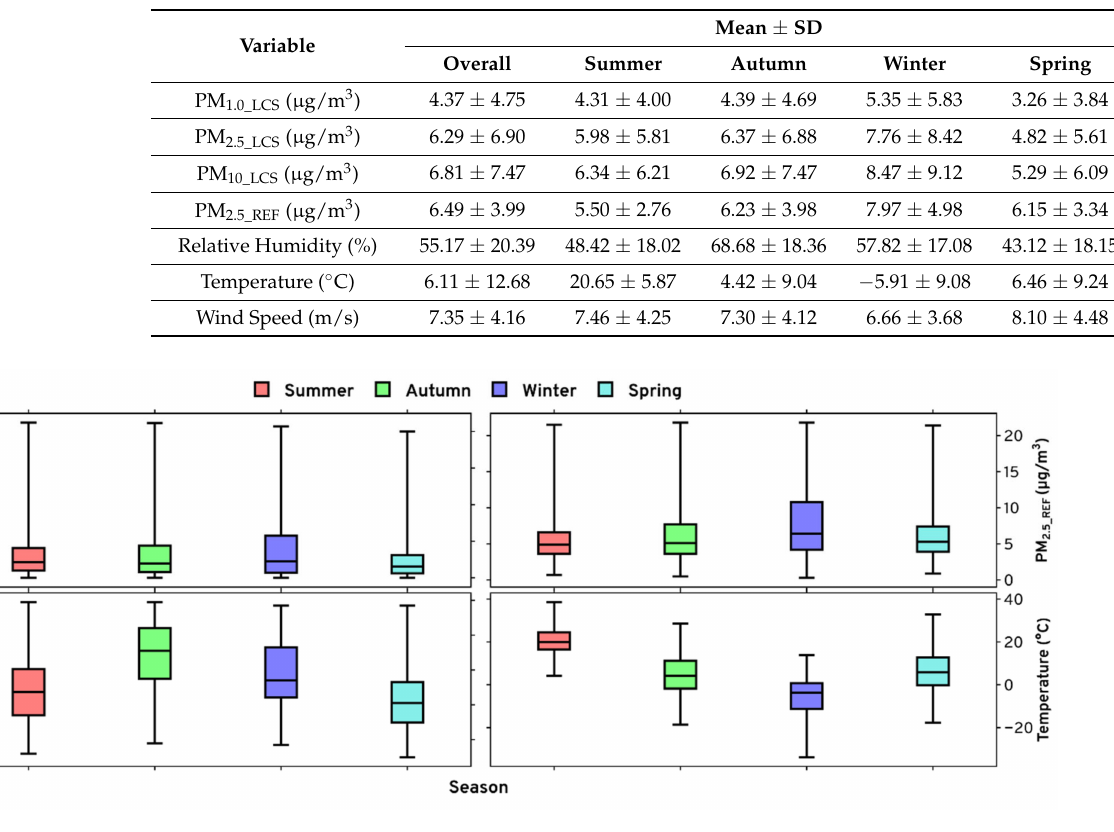
Table 1. Statistical summary of the data used in the study.